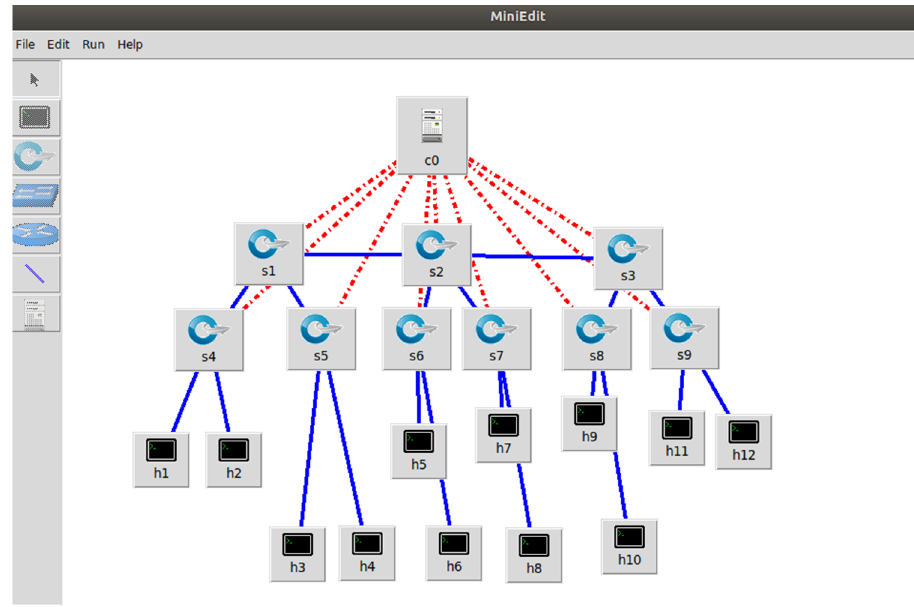
Figure 30. Create tree topology via miniedit.